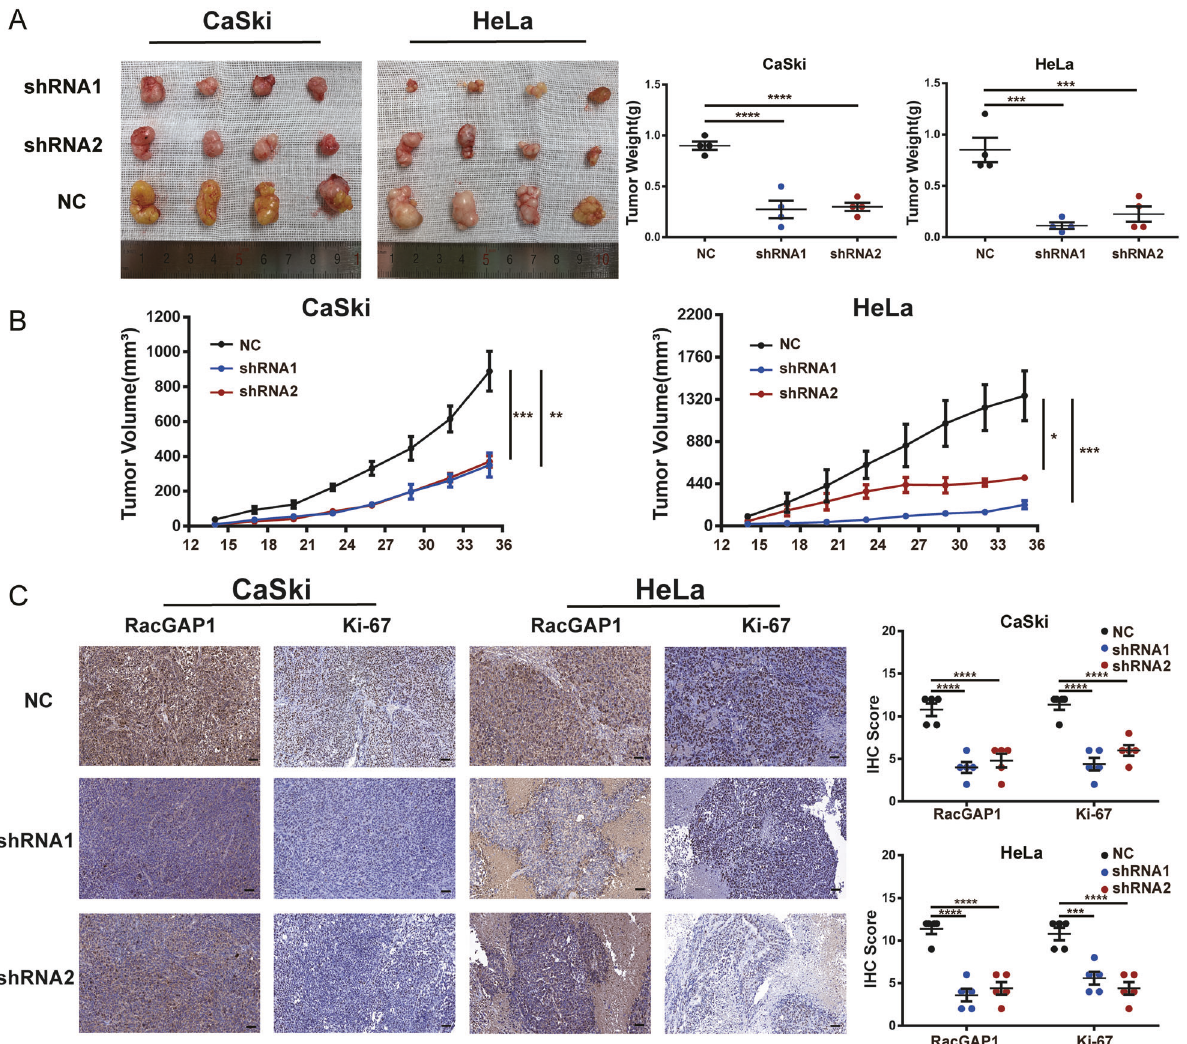
Fig. 4 The effects of RacGAP1 expression on tumorigenesis in vivo. A Images and weights of xenograft tumors. B The growth curves of xenograft tumors. The volumes of tumors were monitored every 3 days. C Representative images of IHC staining of RacGAP1/Ki67 in tumor tissues (magni fi cation, ×400). IHC scores of each group. Data are mean ± SEM, * p < 0.05, ** p < 0.01, *** p < 0.005, **** p < 0.001, n = 4, RacGAP1 Rac GTPase-Activating Protein (Fig. 5A). Among these miRNAs, we found that the expression of miR-192 was negatively correlated with RacGAP1 expression and patients with high expression of miR-192 had a better prognosis (Fig. 5B, C, Fig. S1I). Knocking down RacGAP1 expression could elevate the expression of miR-192 while overexpressing RacGAP1 could decrease the miR-192 expression (Fig. 5D – E). Three CC cell lines were transfected with the miR-192 inhibitor and mimics. The ef fi ciency was measured using qRT-PCR (Fig. S1J). Changing the miR-192 expression didn ’ t in fl uence the RacGAP1 expression (Fig. 5F, Fig. S1L and Original Data 1C). CCK8 and clone formation assays showed that inhibiting miR-192 promoted the proliferation of CC cells while overexpressing miR-192 had opposite effects (Fig. 5G – H, Fig. S1K). Transwell assay and wound healing assay revealed that enhancing the expression of miR-192 decreased the migration and invasion ability of CC cells while decreasing expression was on the contrary (Fig. S2). The RIP-PCR results indicated that miR-192 expression had no statistical difference between groups of RacGAP1 pulldowns and IgG controls (Fig. 5I). As a transcriptional factor of mir-192,